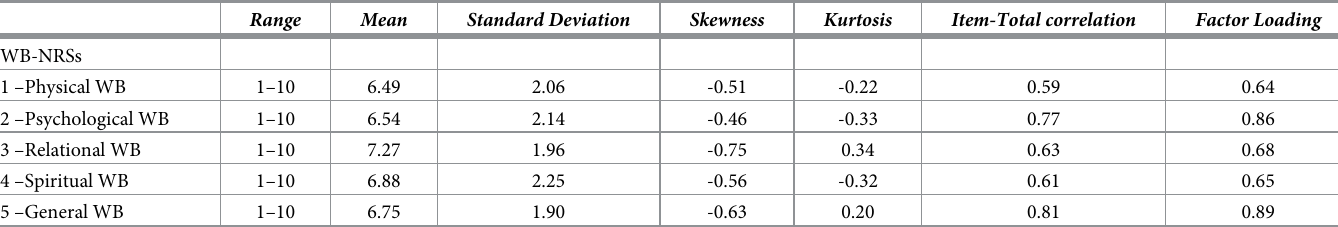
Table 1. Descriptives, item-total correlations (with item deleted), and factor loadings of the Well-being Numerical Rating Scales (WB-NRSs). Range Mean Standard Deviation Skewness Kurtosis Item-Total correlation Factor